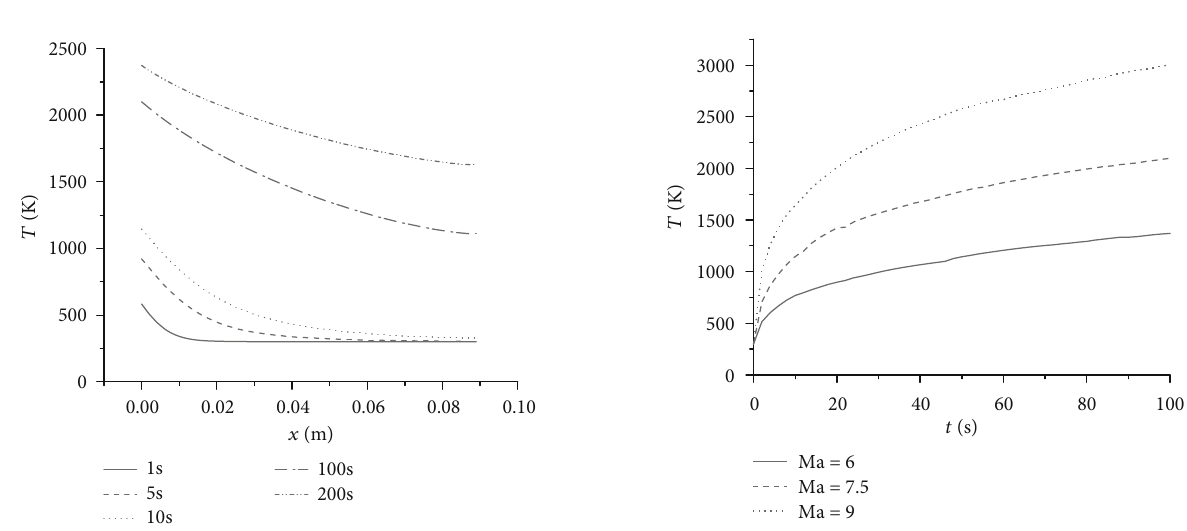
Figure 18: Temperature distribution along the axis. Figure 20: E ff ect of the Mach number on the highest temperature.